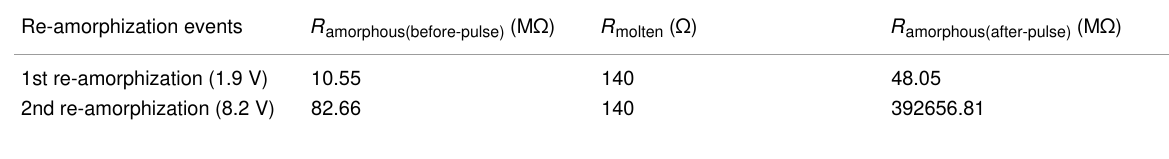
Table 2: Cell resistance values, R cell , used for the two re-amorphization events in the simulations. Re-amorphization events